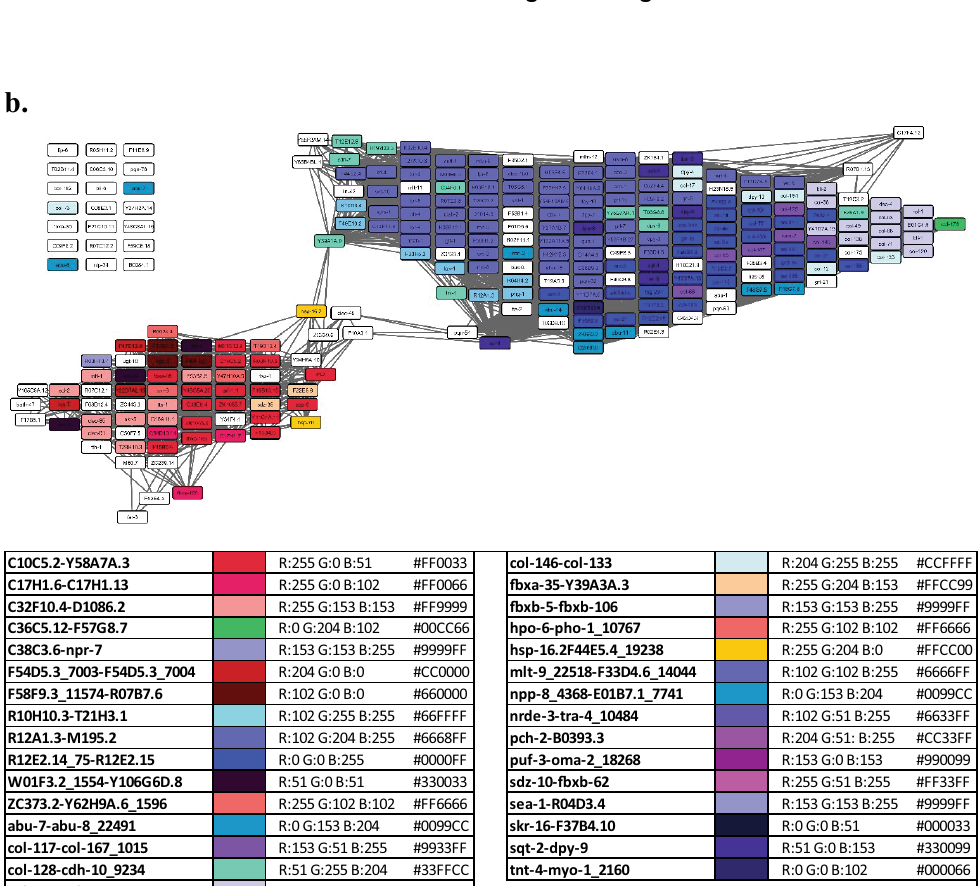
Figure 4. Correlation between daf-16 target genes and identified cliques for those genes most clearly enriched in daf-16 targets. ( a ) Enrichted target cliques of DAF-16. The plot shows how many genes per clique are derived from the indicated range of the DAF-16 ranking. Cliques with high percentage values on the left side reflect cliques that are considered to be DAF-16 activatable while cliques with a low percentage up to the bottom to the DAF-16 ranking are considered repressed. ( b ) Most strongly enriched cliques in the Top750 and Bottom750 of the ranked daf-16 target